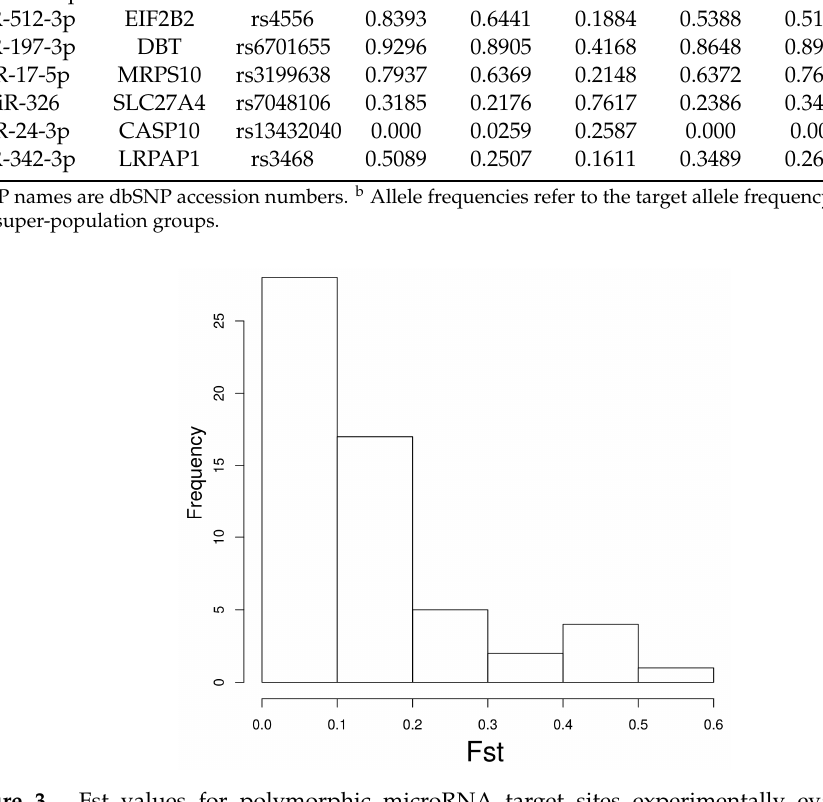
Table 3. Wilcoxon signed-rank (paired) test between African and European target allele frequencies in TargetScan predicted microRNA target sites.